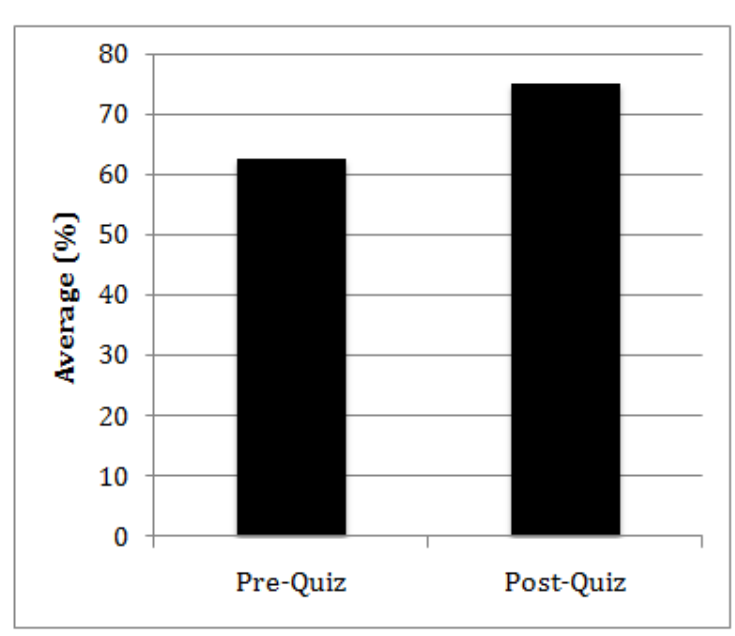
Figure 13. The overall average for the control group for the question regarding drawing a parallel